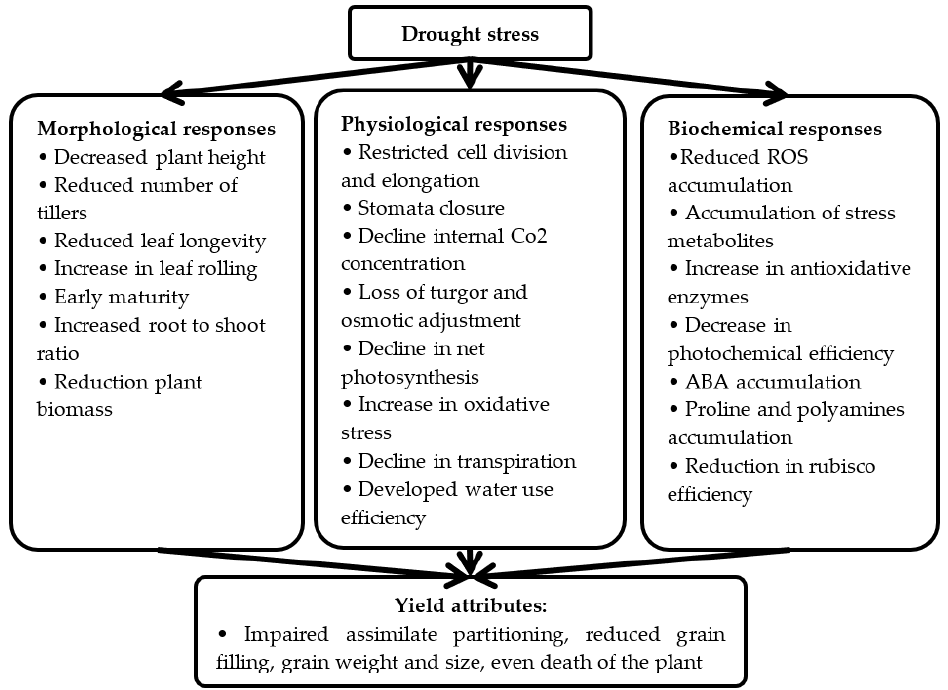
/ yield decline in plants under drought stress Figure 1 Figure 1. Annotation mechanisms of growth